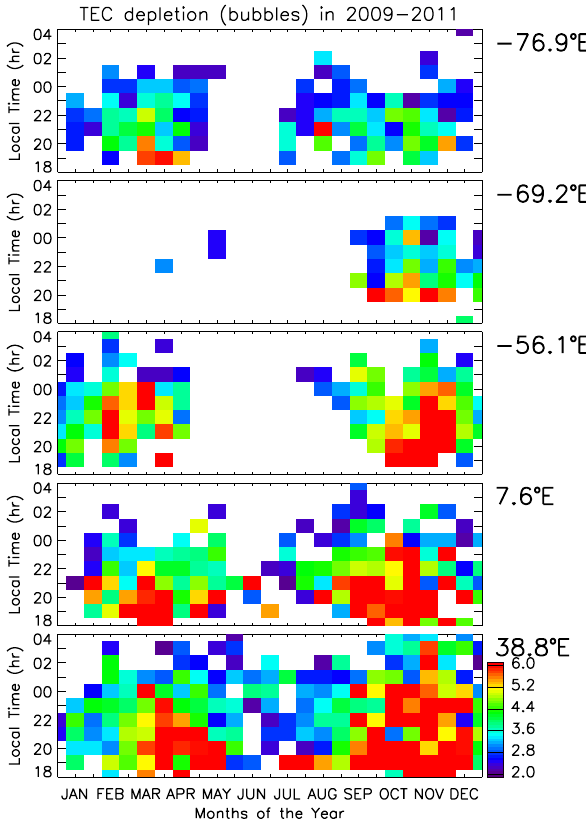
Fig. 6. The distribution of bubbles/irregularities, estimated from GPS TEC recorded from 2009 to 2011, as a function local time versus months. The different panels represent different longitudinal sectors, which are given at the right side of each panel. The color index represents the TEC depth (the TEC difference between tough and crust region of the